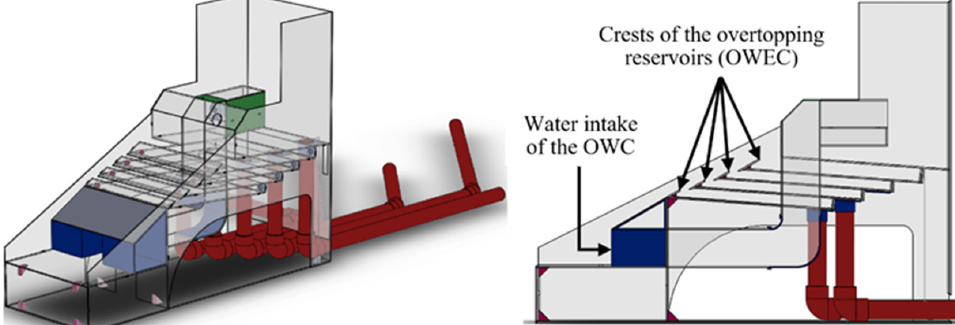
Figure 3. Hybrid WEC model scheme for construction in SolidWorks ® . Reproduced with permission from [42]. Copyright 2020, Elsevier.